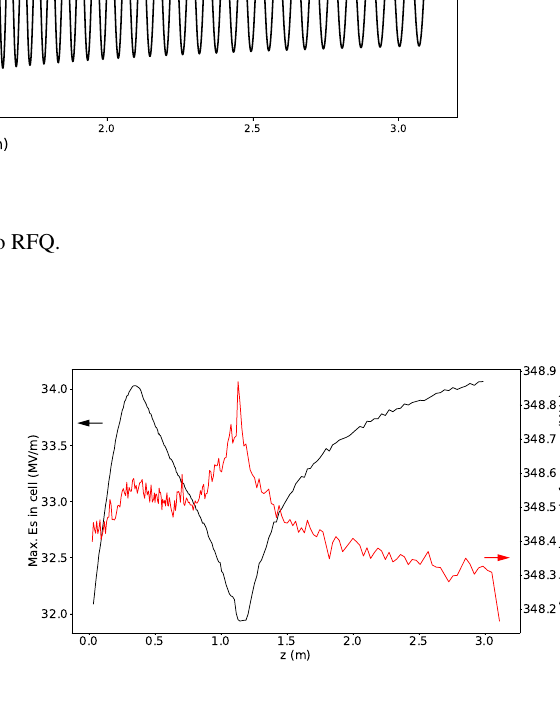
Figure 6. Surface maximum electric field per cell (left) and local frequency (right) as a function of cell starting coordinate z . Fre- quency is calculated in a slice of RFQ with one cell length and no